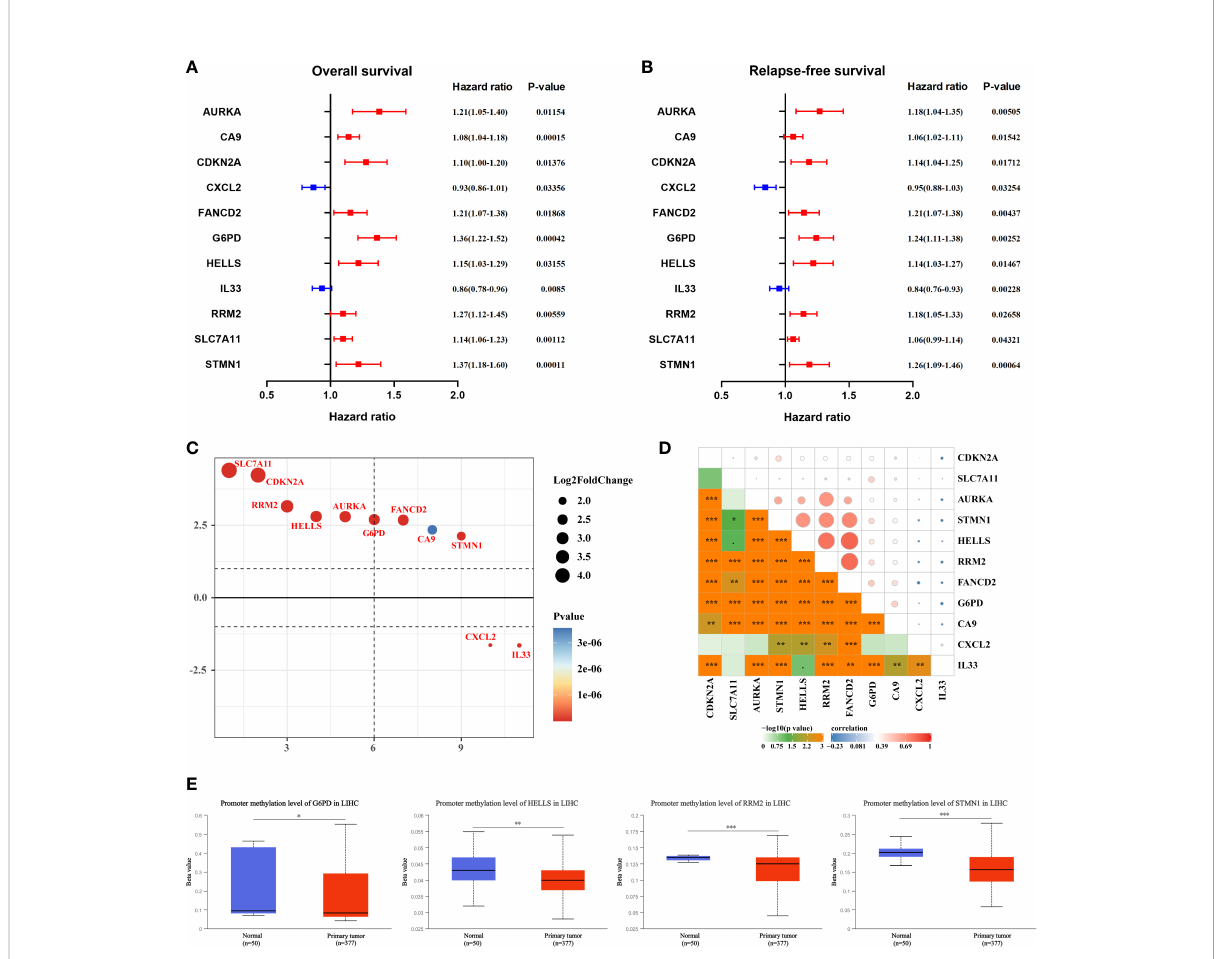
FIGURE 2 Selection of hub ferroptosis-related differentially expressed genes. (A, B) Forest plot for the univariate Cox regression analysis of OS and RFS with 11 FRGs. P-value <0.05 exhibited statistical signi fi cance. (C) The differential expression ranking of 11 hub FGRs. (D) Pearson ’ s correlation analysis of 11 FRGs in TCGA-LIHC. *P <0.05; **P <0.01; ***P <0.001. (E) The methylation levels of G6PD, HELLS, RRM2, and STMN1 in HCC and peri-tumor tissues were determined using the UALCAN